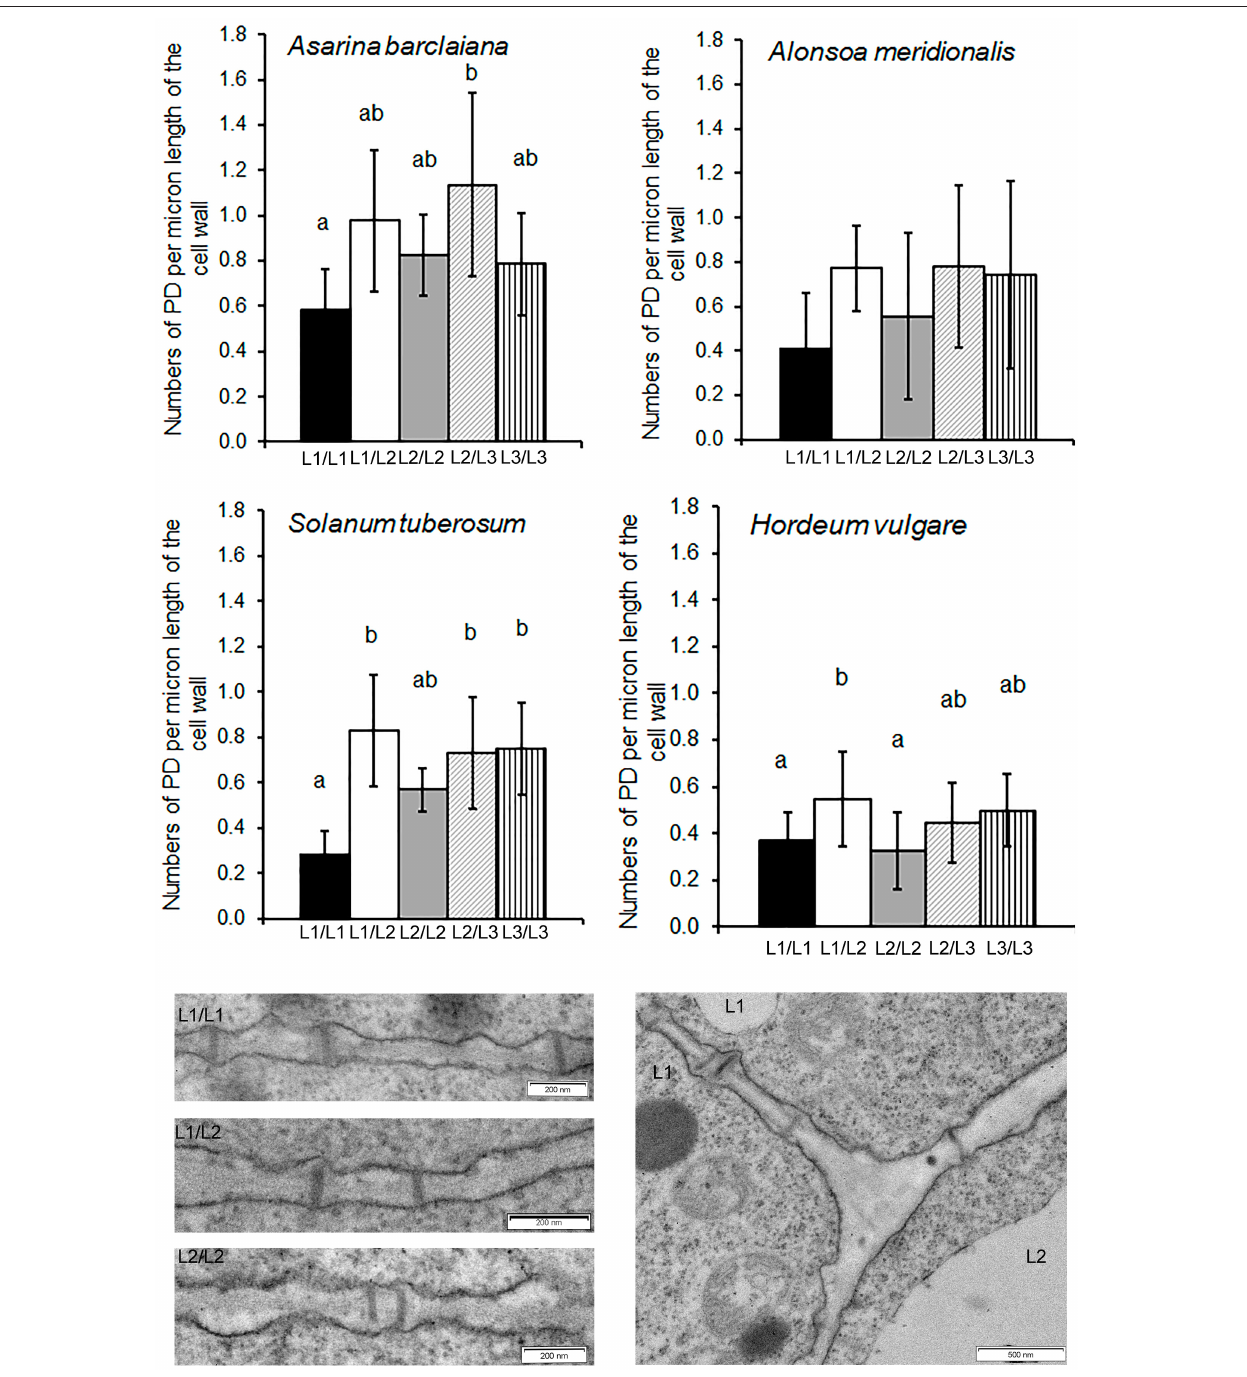
FIGURE 4 | Quantitative estimates for PD between different cells/layers in shoot apical meristems of A. meridionalis , A. barclaiana , potato, and barley. PD frequencies are expressed as numbers of PD per µ m length of cell wall as found on transverse sections through the cell wall. Data represent average values for 6–25 cells ± SE. Different letters indicate significant differences at p < 0.05 according to one-way ANOVA with post hoc Tukey’s test. Data for barley are reproduced from Dmitrieva et al. (2017). Micrographs show PD in one of the Solanum tuberosum apices examined. L1 and L2 mark cells of the corresponding cell layers.